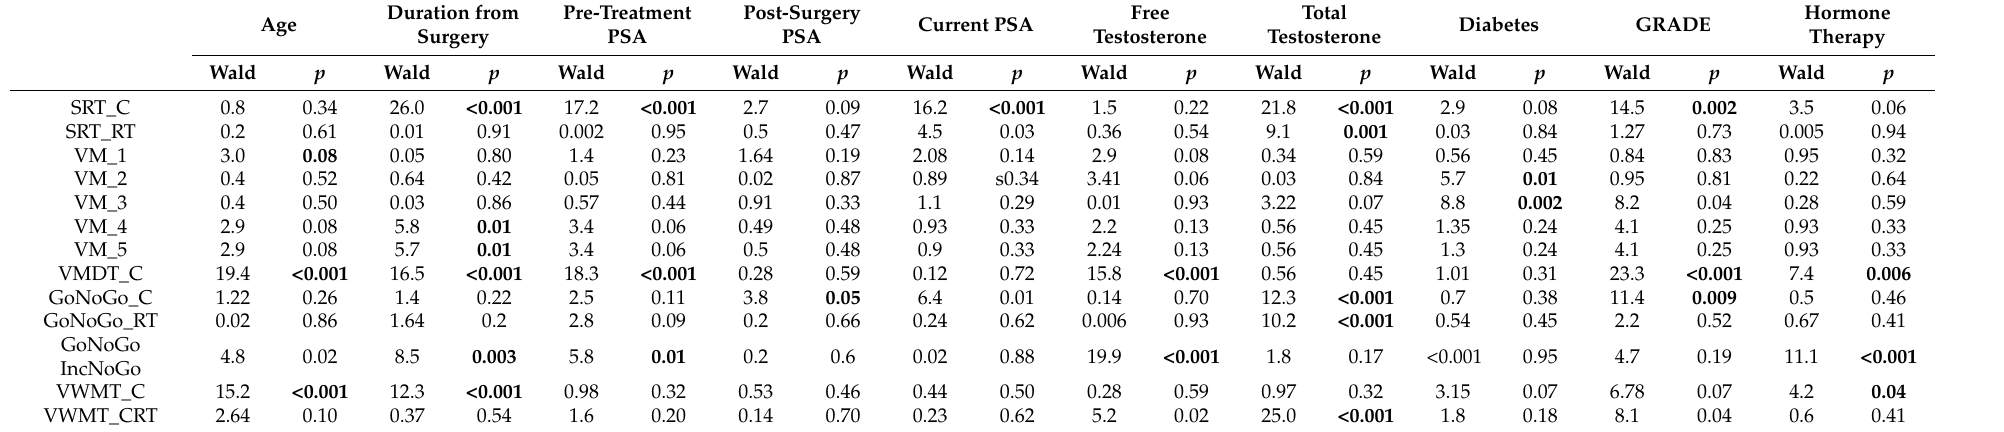
Table 6. Analysis of the covariance (ANCOVA) of the factors determining the parameters of neuropsychological